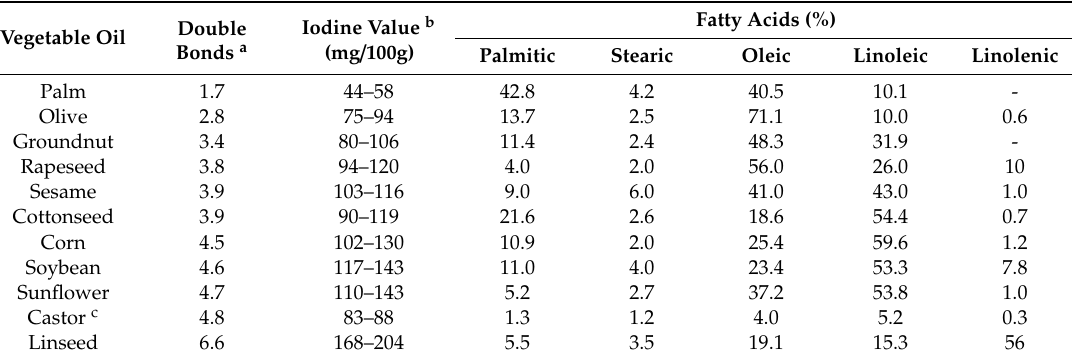
Table 2. Properties and fatty acid compositions of the most frequent vegetable